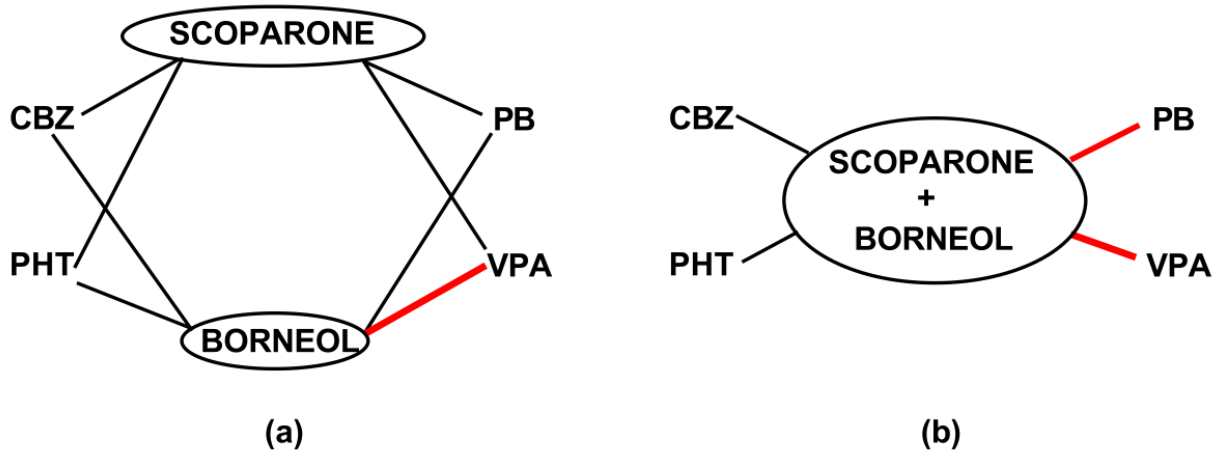
Figure 5. Polygonogram illustrating interactions for two-drug ( a ) and three-drug ( b ) mixtures among scoparone, borneol and four classic antiseizure medications in the mouse MES model. Black lines illustrate the additive interactions, whereas the red lines indicate synergistic interactions.